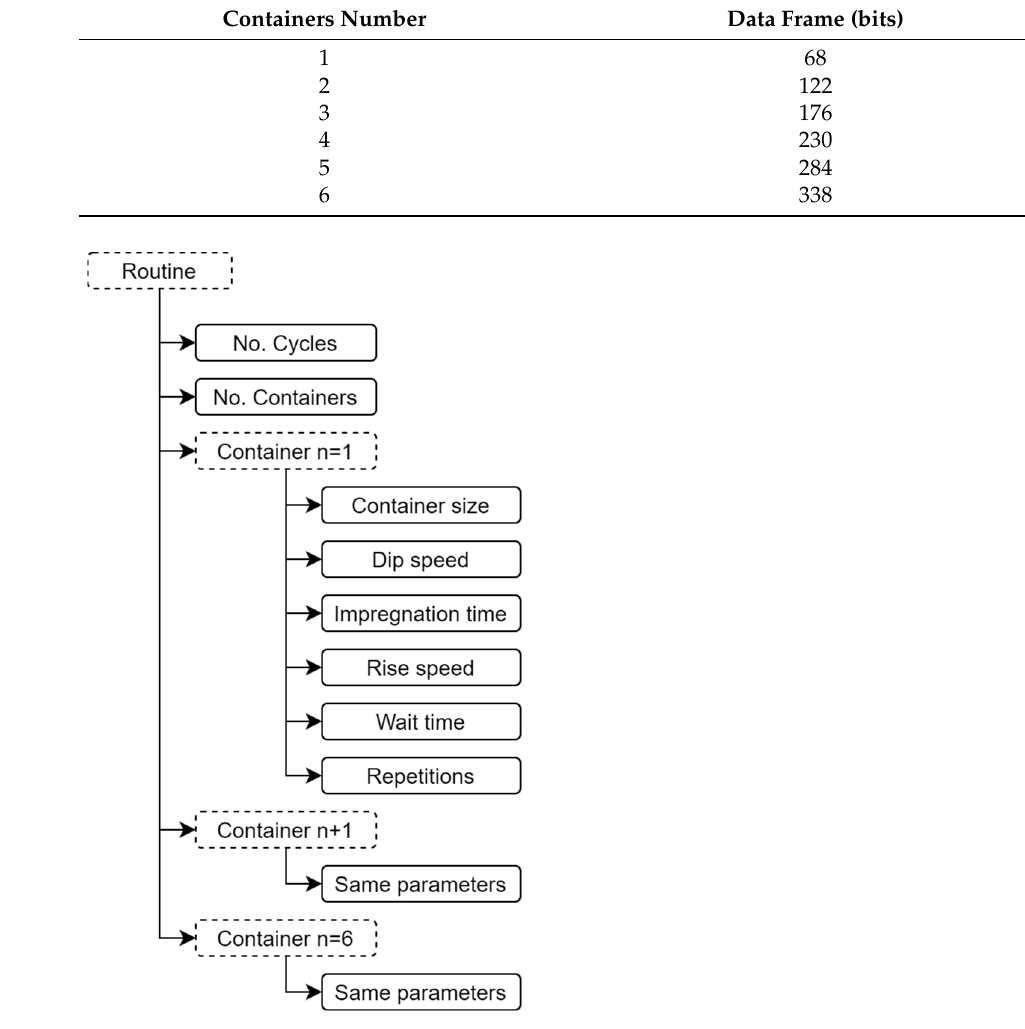
Figure 6. Specific parameters to be configured by each routine of the virtual control panel of the mechanical system.